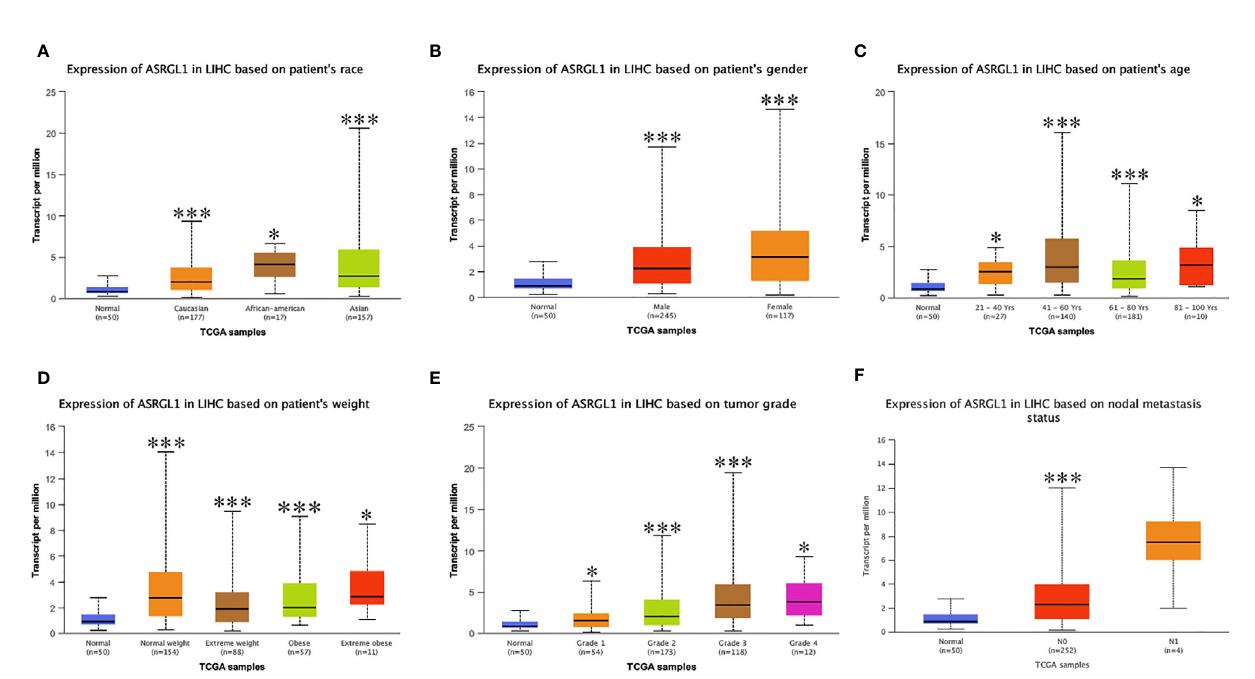
FIGURE 2 | The mRNA expression of ASRGL1 in subgroups of patients with HCC, strati fi ed based on sex, age, and other criteria (UALCAN). Box-whisker plots showing the expression of ASRGL1 in subgroups of LIHC samples. (A) The mRNA expression of ASRGL1 in healthy and HCC samples. (B) The mRNA expression of ASRGL1 in healthy individuals of either sex and in male or female patients with LIHC, respectively. (C) The relative mRNA expression of ASRGL1 in normal individuals of any age or in patients with LIHC between 21 and 40, 41 and 60, 61 and 80, and 81 and 100 years of age. (D) The relative expression of ASRGL1 in healthy ” patients subjects and African American, Caucasian, and Asian patients with HCC. (E) The mRNA expression of ASRGL1 in healthy individuals in patients with stages 1, 2, 3, or 4 HCC. (F) The mRNA expression of ASRGL1 in healthy individuals or patients with grade 1, 2, 3, or 4 HCC tumors (central mark: the median; edges of the box: the 25 th and 75 th percentiles). The t -test was used to estimate the signi fi cance of differences in gene expression levels between groups. *p < 0.05; **p < 0.01; ***p <